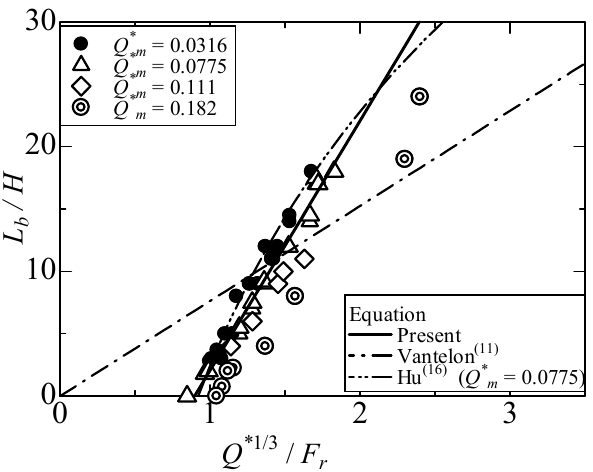
Fig. 7 Relationship between L b / H and Q *1/3 / Fr . Four types of symbols show the dimensionless average heat release rate Q * m in the range from 0.0316 to 0.182. The solid line, chained line, and double-dashed chained line represent Eqs. (3), (2), and (4), respectively.